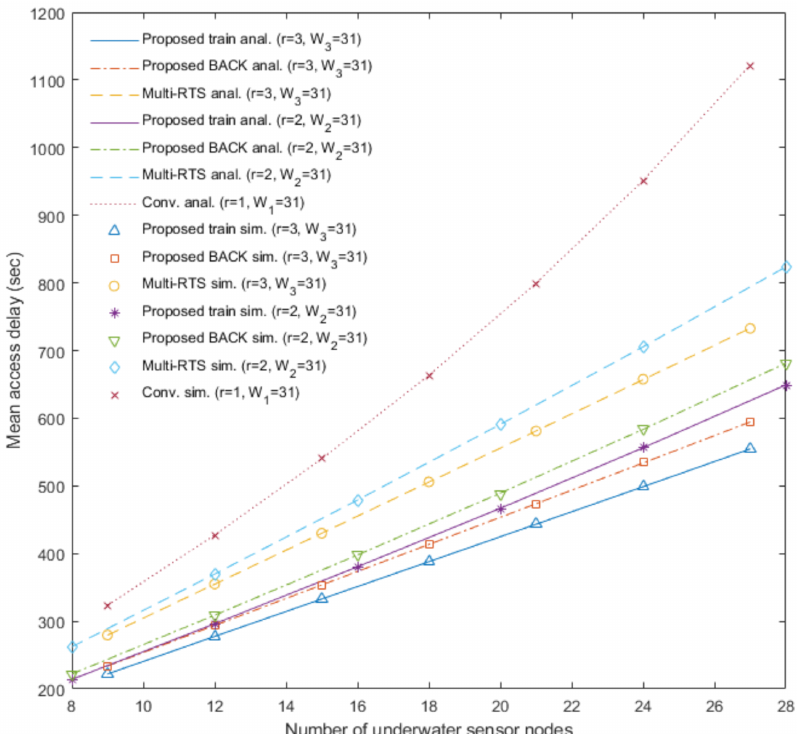
Figure 5. Mean access delay of the proposed underwater multi-DATA train protocol, the proposed underwater BACK protocol, and the underwater multi-RTS reception protocol with r = 2 and r = 3, and the conventional CSMA / CA protocol with r =